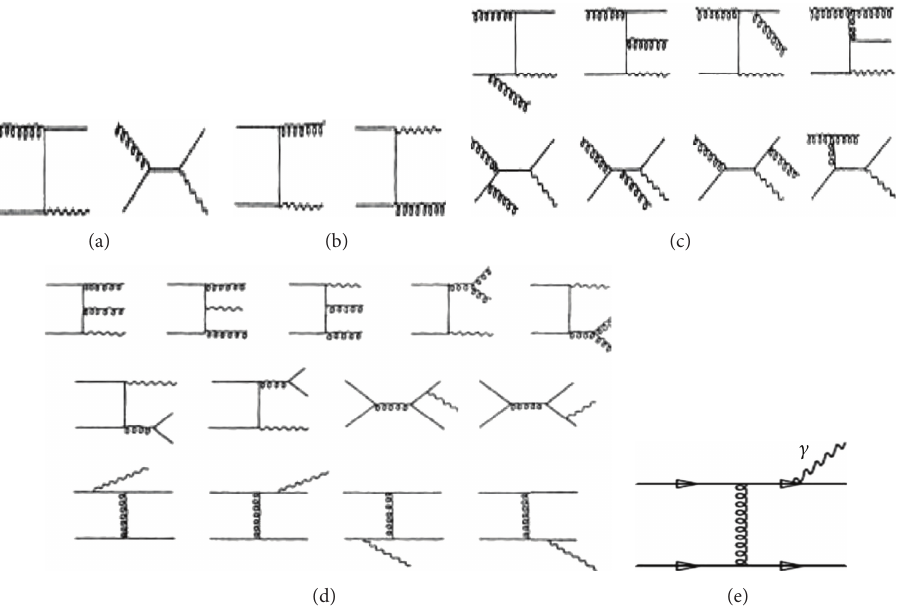
Figure 4: Partonic processes for production of